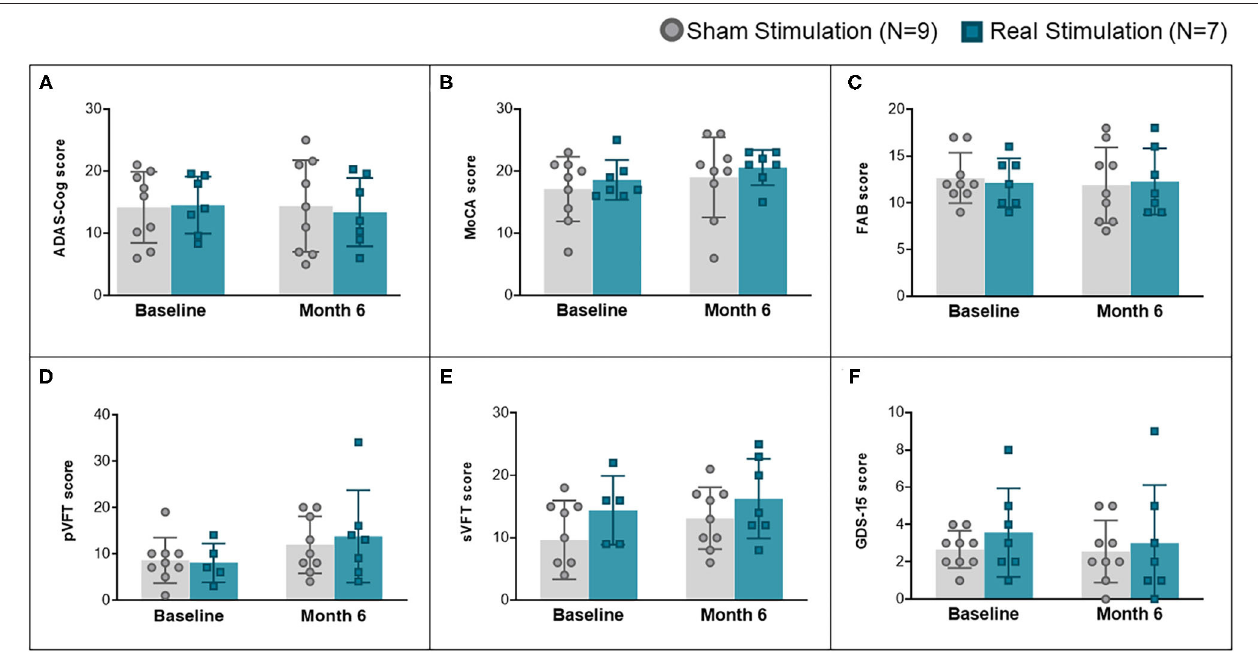
FIGURE 3 | Changes in secondary outcome scores over time, including all cognitive assessments and depression assessment. (A) Comparison of ADAS-Cog score at baseline and after 6 months of treatment. (B) Comparison of MoCA scores at baseline and after 6 months of treatment. (C) Comparison of FAB scores at baseline and after 6 months of treatment. (D) Comparison of pVFT scores at baseline and after 6 months of treatment. (E) Comparison of sVFT scores at baseline and after 6 months of treatment. (F) Comparison of GDS-15 scores at baseline and after 6 months of